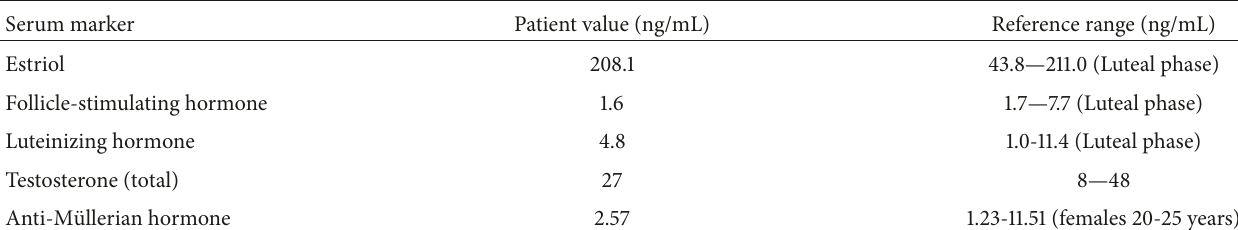
Table 1: Biochemical evidence of female